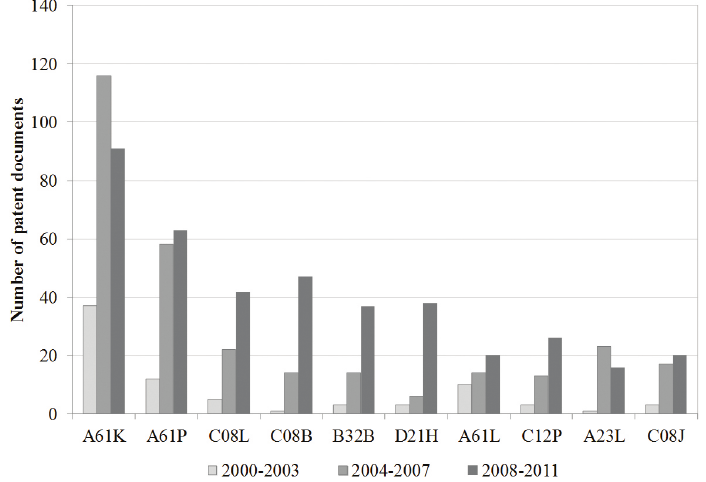
Figure 3. Evolution of the top 10 technological subjects. Source: USPTO. Table 1. Types of nanocellulose to the top technological subject. Technological